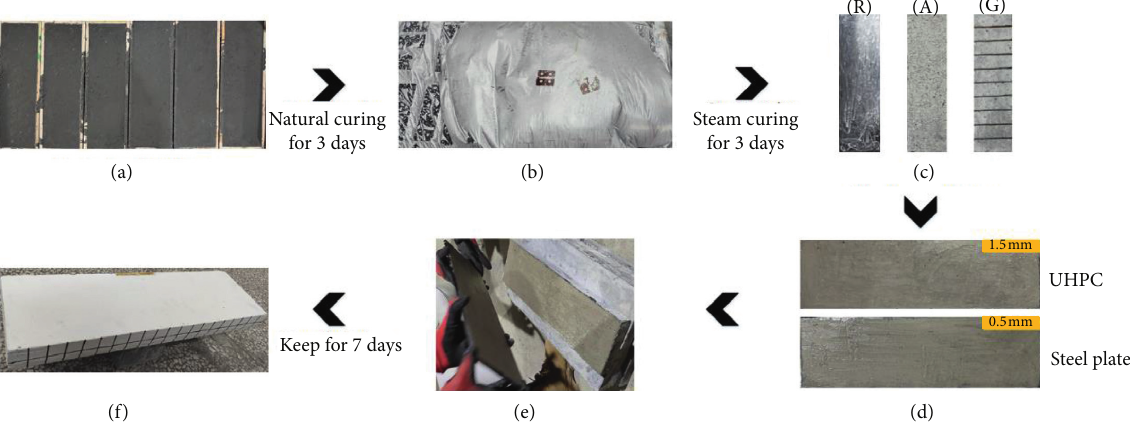
Figure 2: The whole manufacturing process of the specimen. (a) Cast in situ UHPC. (b) Steam curing. (c) Surface treatment. (d) Apply epoxy adhesive. (e) Install steel plate. (f) Formed